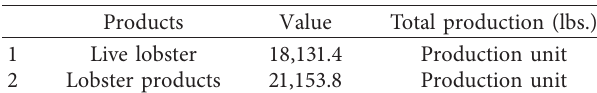
Figure 3: Supply chain design (screenshot from anyLogistix ™ ). (i) March 15: consumption for live lobsters drops around 30%. (ii) April 15: production line for live lobster shutdown. (iii) April 20: DCs temporarily closed. (iv) May 6: DCs reopen. (v) May 15: production line for live lobsters reopen. Table 1: Total